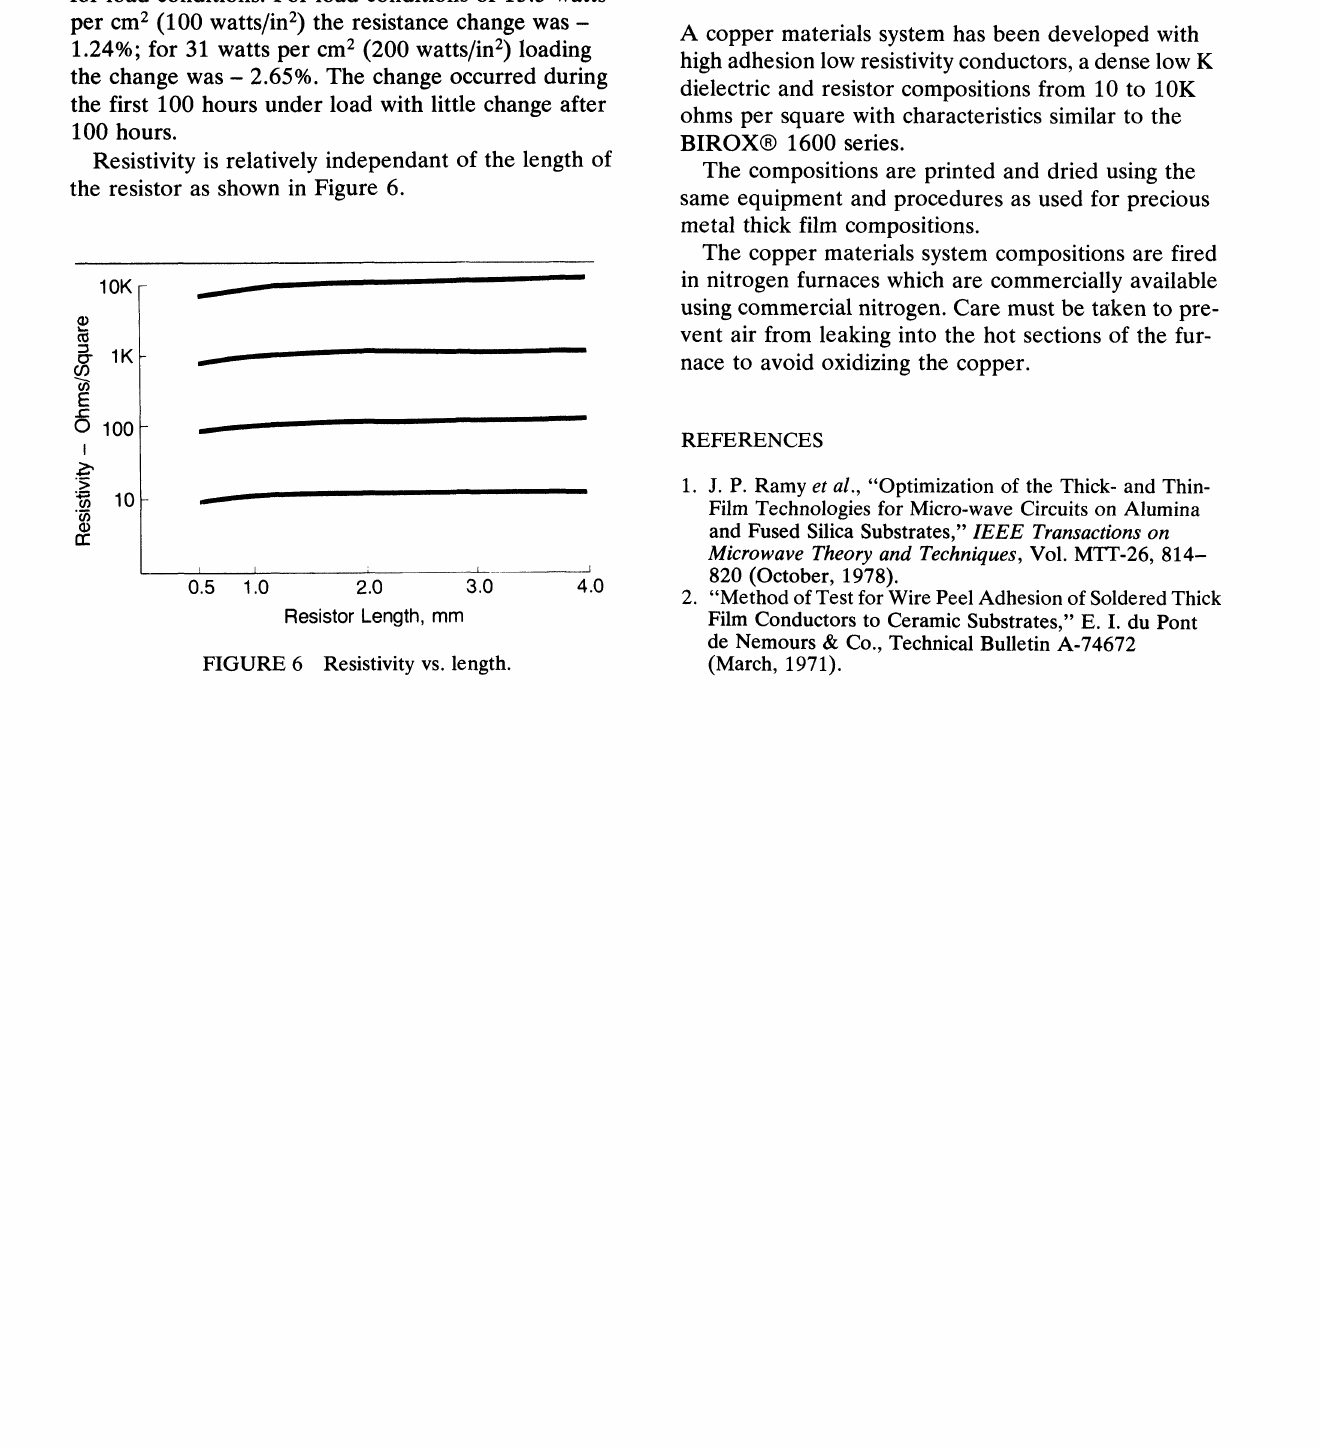
FIGURE 6 Resistivity vs.